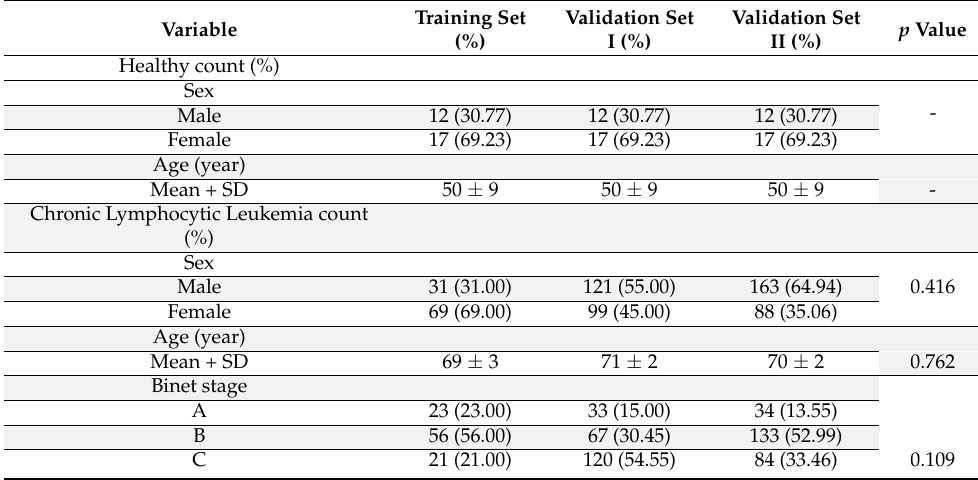
Table 1. Clinical features of the studied